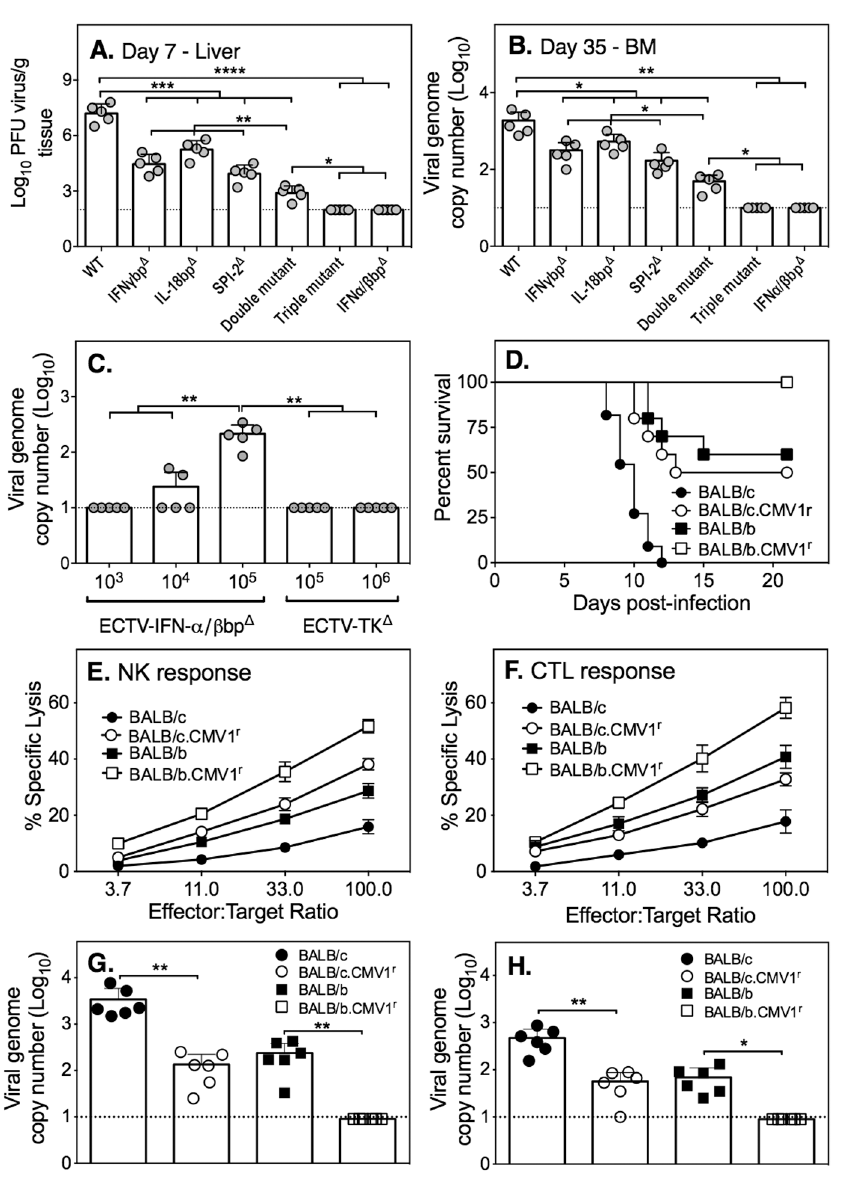
Fig 5. The effect of virus-encoded HRM and host resistance loci on virus persistence. Groups of 5 female BALB/c mice were infected with 100 PFU of WT, IFN- γ bp Δ , IFN- α / β bp Δ , IL-18bp Δ , SPI-2 Δ , IFN- γ bp Δ - IL-18bp Δ (double mutant) IFN- γ bp Δ -IL-18bp Δ -SPI-2 Δ (triple mutant) ECTV. Separate groups of mice were sacrificed on days 7 and 35 to measure viral load. (A) Viral load in the liver at day 7 p.i. (B) Virus genome copy numbers in the BM at day 35 p.i. (C) Viral genome copy numbers in the BM of BALB/c mice 35 days p.i. with varying doses of ECTV-IFN- α / β bp Δ or of ECTV-TK Δ . For (A), (B) and (C), * , P < 0.05; ** , P < 0.01; *** , P < 0.001; **** , P < 0.0001. (D) Survival of WT (BALB/c, BALB/b) and congenic (BALB/c. Cmv 1 r , BALB/b. Cmv 1 r ) mice infected with 500 PFU ECTV-WT. P values were obtained by Log-rank (Mantel-Cox) test: P < 0.001 in comparing % survival of BALB/c with BALB/c. Cmv 1 r ; P < 0.05 in comparing % survival of BALB/b with BALB/b. Cmv 1 r ; P < 0.0001 in comparing % survival of BALB/c with BALB/b; P < 0.05 in comparing % survival of BALB/c. Cmv 1 r with BALB/b. (E) NK cell and (F) CTL responses at day 7 p.i. in WT and congenic mice infected with 100 PFU ECTV-WT. (G) Virus genome copy numbers in the BM at day 35 p.i. in WT and congenic mice infected with 100 PFU ECTV-WT. (H) Virus genome copy numbers in the BM at day 35 p.i. in WT and congenic mice infected with 10 5 PFU of ECTV-IFN- α / β bp Δ . The limit of virus detection in A is 2 log 10 PFU, shown by a dotted line. The limit of virus genome detection in B, C, G and H is 10 copies, shown by the dotted line. For panels A-C, G and H, P values were obtained by Mann-Whitney U test for the indicated comparisons: * , P < 0.05, ** , P < 0.01, *** , P < 0.001 and **** , P < 0.0001.